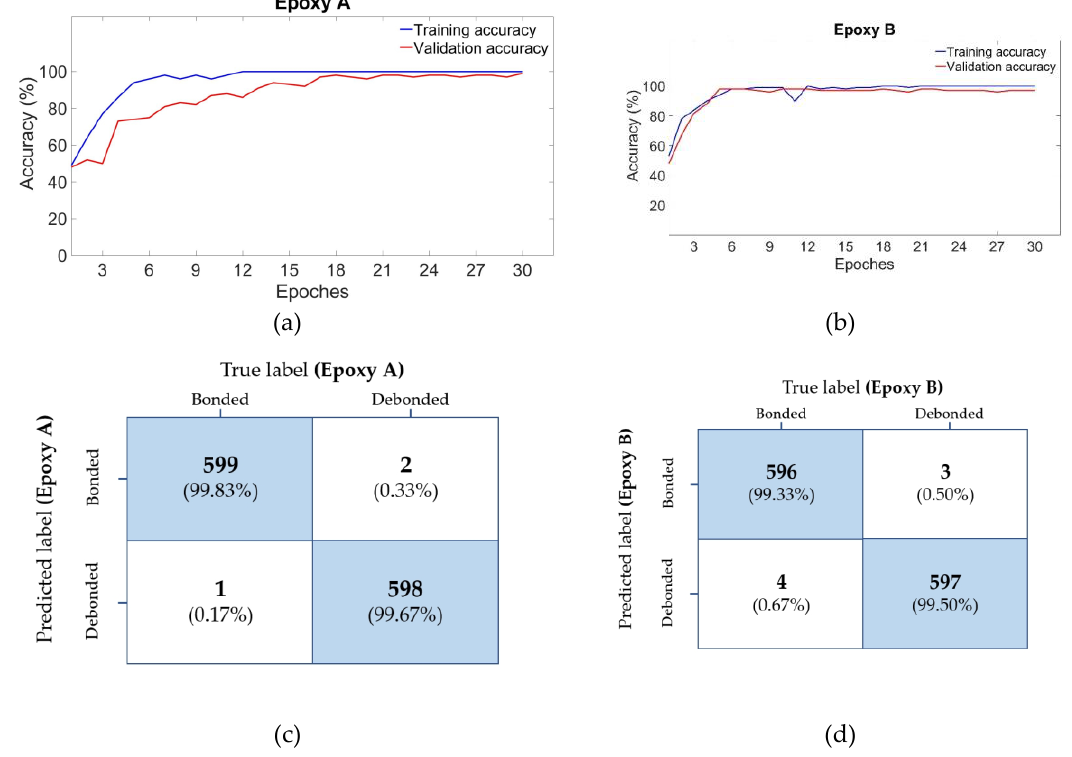
Figure 13. Performance curves of the training and validation subsets for ( a ) epoxy A and ( b ) epoxy B. Confusion matrix of the performance test subsets of the CNN for ( c ) epoxy A and ( d ) epoxy